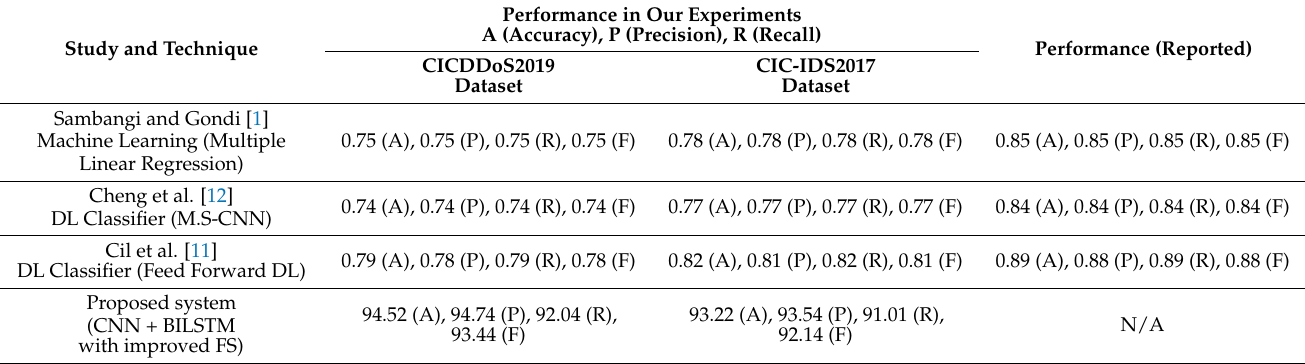
Table 13. The suggested model and baseline results are compared (A: Accuracy, P: Precision, R: Recall, and F: F1.